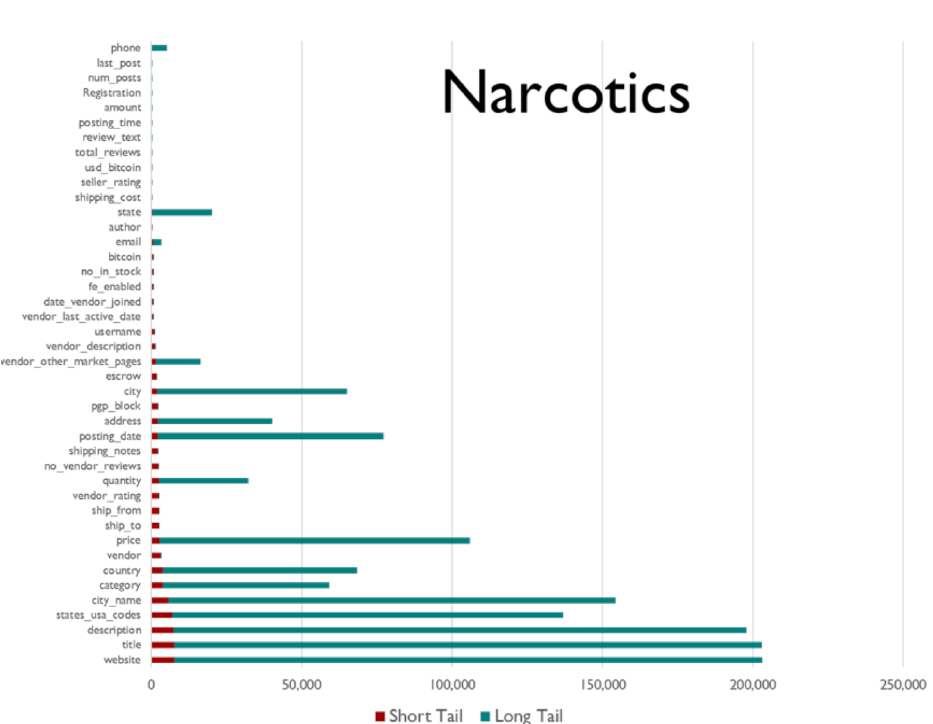
Figure 11. For the Narcotics domain, a comparison of web page count (x-axis) such that at least one value per field (y-axis) was extracted from that website (green bar/long tail), against the short tail/red bar wherein only Inferlink extractions are considered.